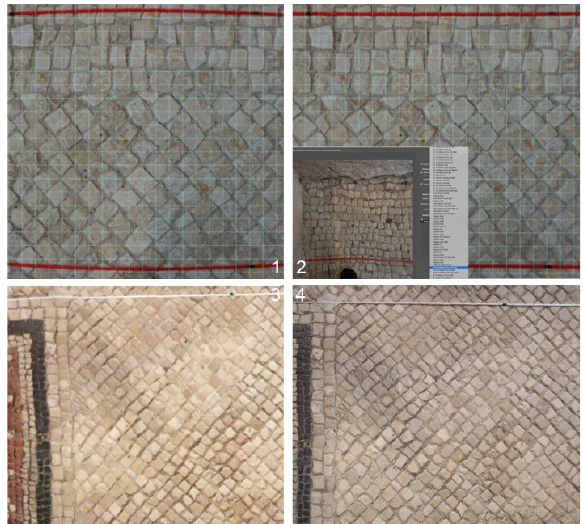
Figure 10. 2D photography optical aberration (1) and lens correction (2); integration of 2D photogrammetry and SfM photogrammetry to gain a better orthomosaic quality for the tiles vectorialization (3,